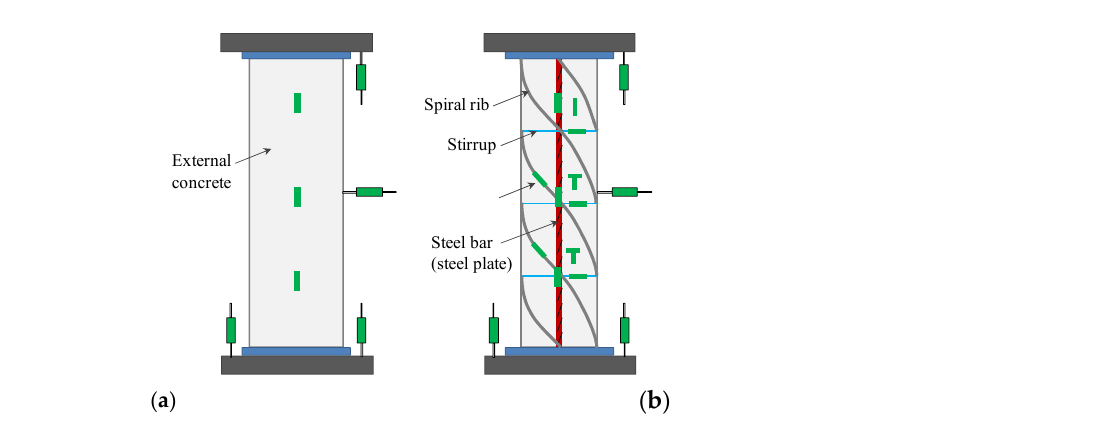
Figure 2. Displacement meter and strain gauge arrangement. ( a ) External concrete ( b ) Steel pipe.